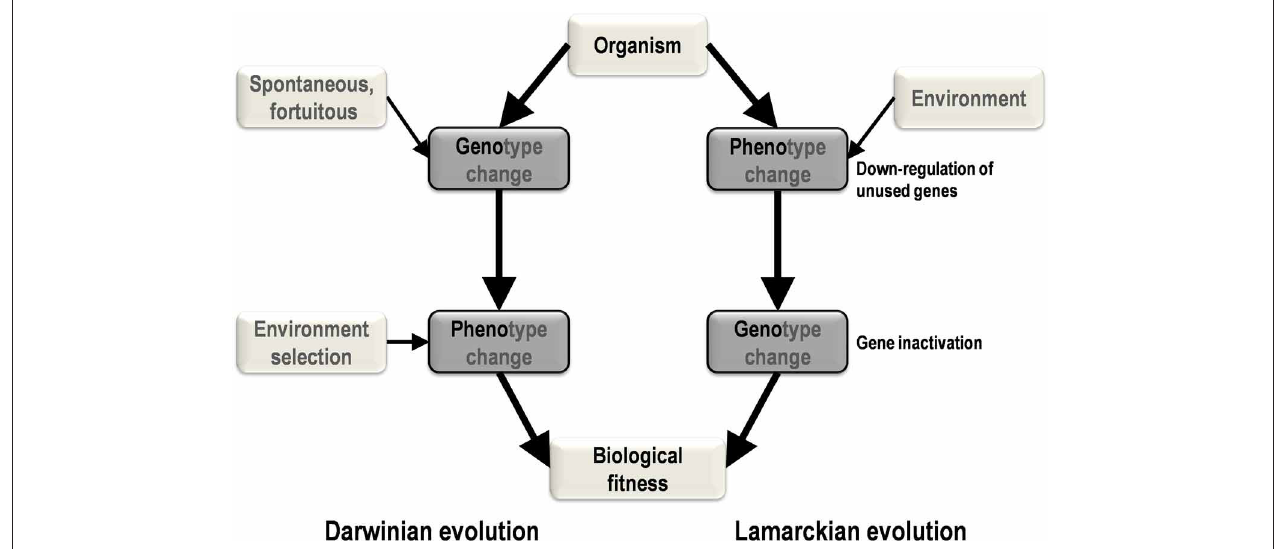
FIGURE 1 | A schematic diagram of the major steps and causes and effects in Darwinian and Lamarckian evolution. In Darwinian evolution (left), genotypic change precedes phenotypic change, whereas these changes occur in the opposite order in Lamarckian evolution (right).